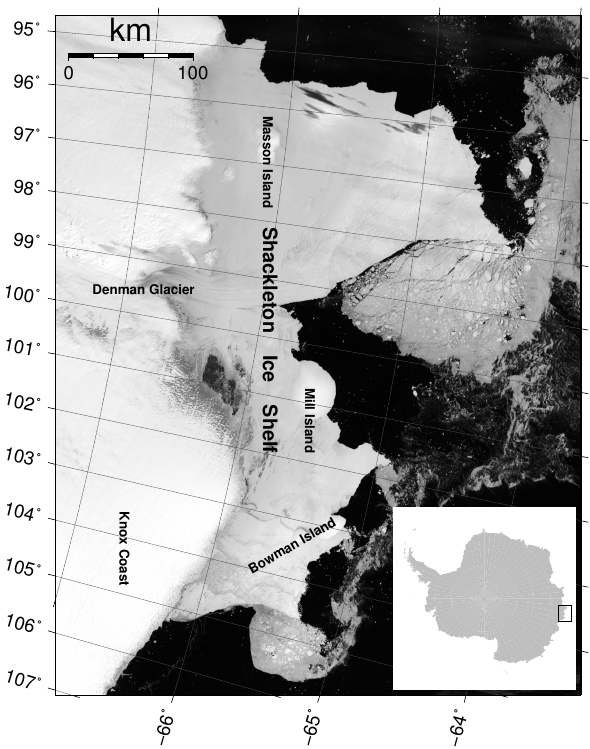
Fig. 1. Moderate Resolution Imaging Spectroradiometer (MODIS) image of Mill Island and surrounds, from Scambos et al. (2011) with modification.